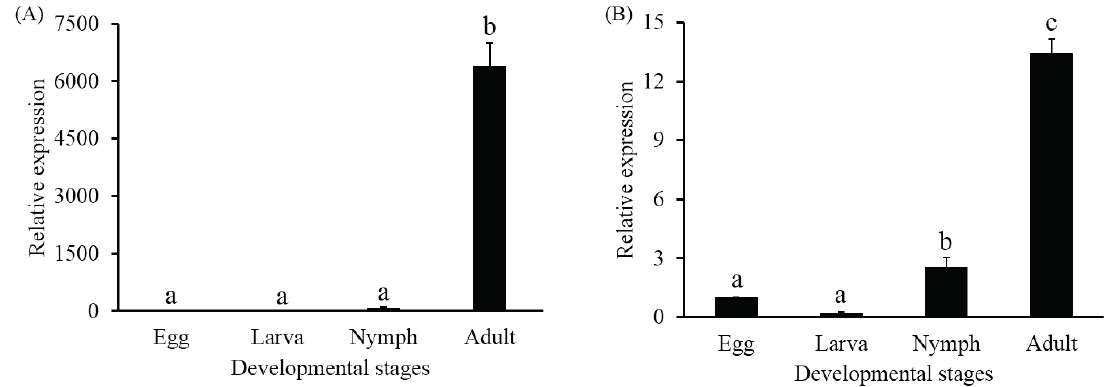
Figure 4. Expression profiles analysis of vitellogenin 1 ( PcVg1 ) ( A ) and vitellogenin receptor ( PcVgR ) ( B ) of Panonychus citri at different developmental stages. The